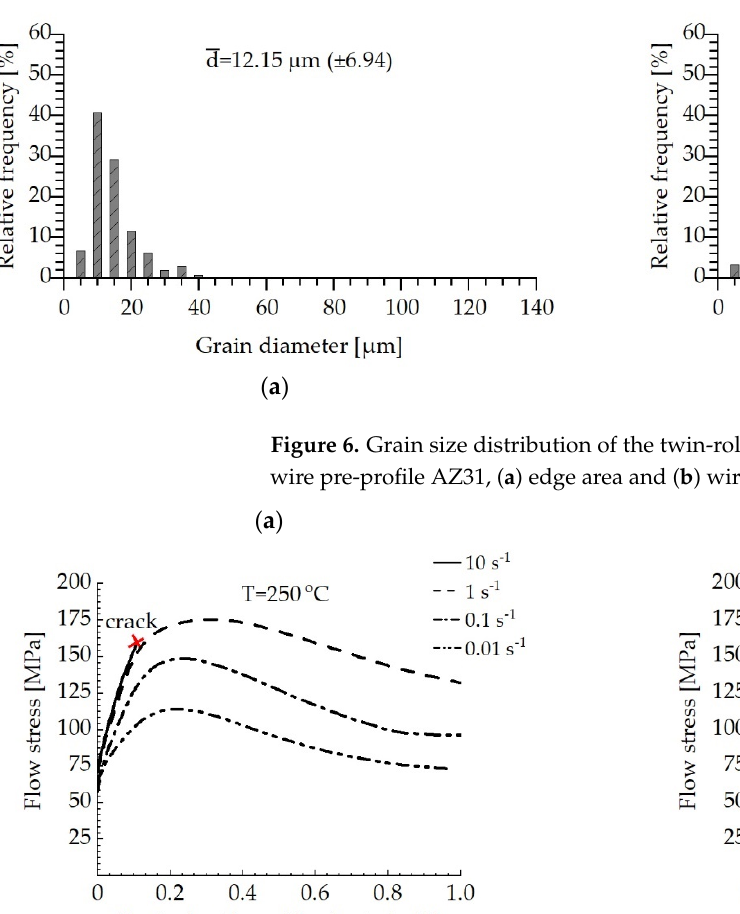
Figure 6. Grain size distribution of the twin-roll cast and heat-treated (460 °C/15 min) magnesium wire pre-profile AZ31, ( a ) edge area and ( b ) wire centre.